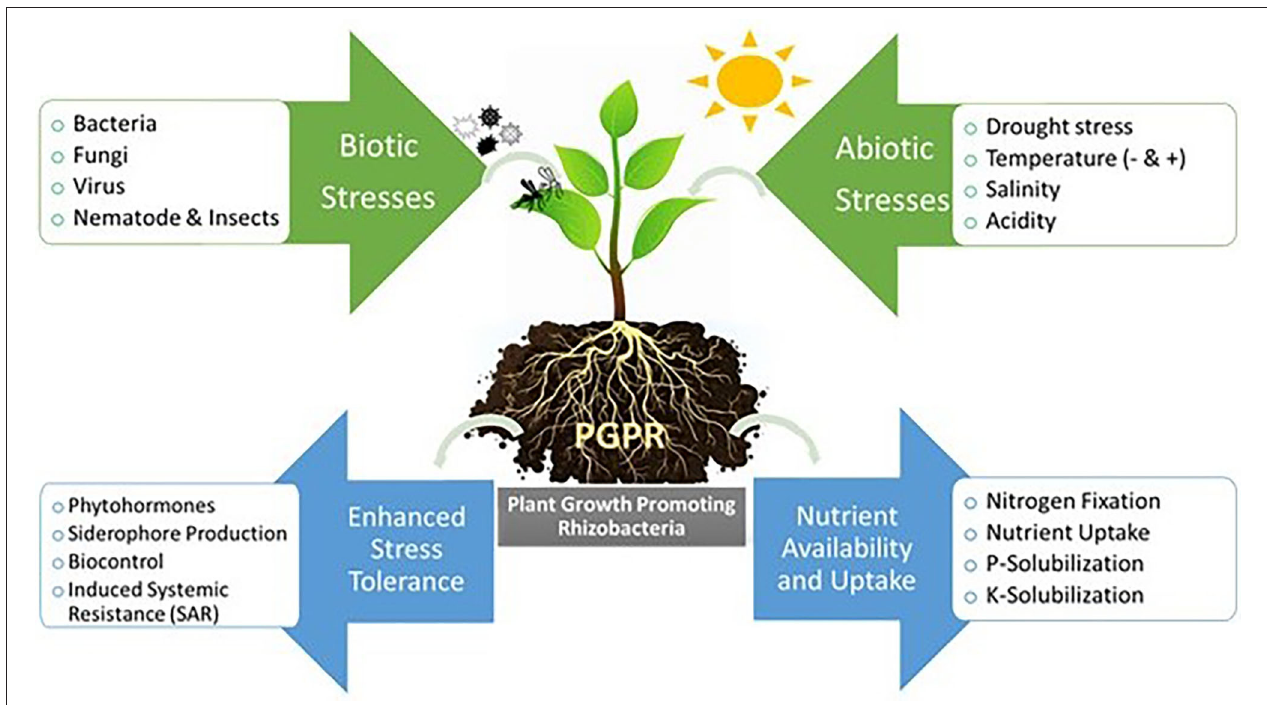
FIGURE 1 | Plant growth promoting rhizobacteria (PGPR) and plant interactions in